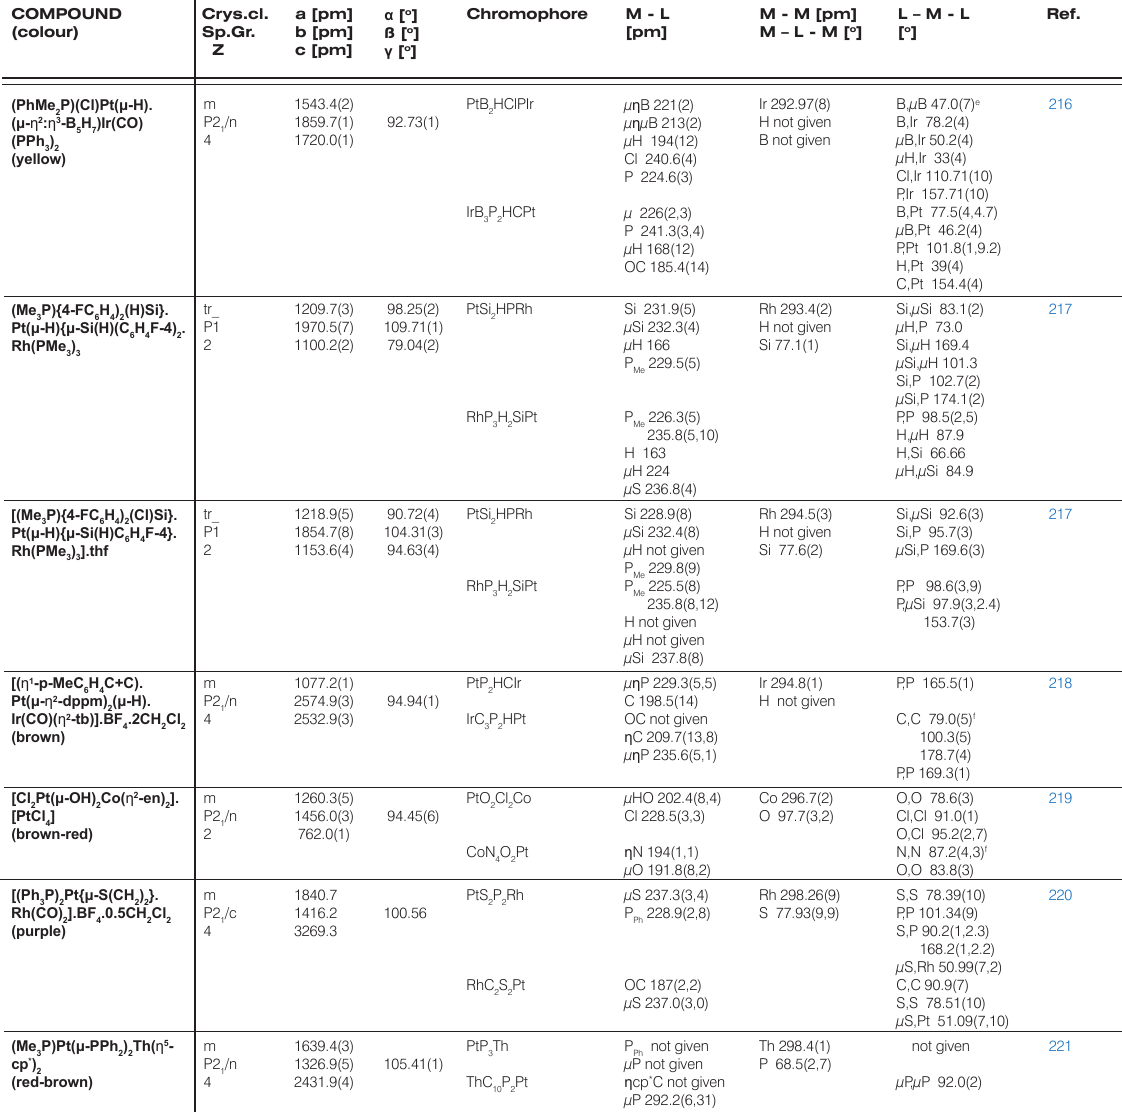
235.5 (PtPPh ). The first two sequences follow the steric 3 effects of the respective